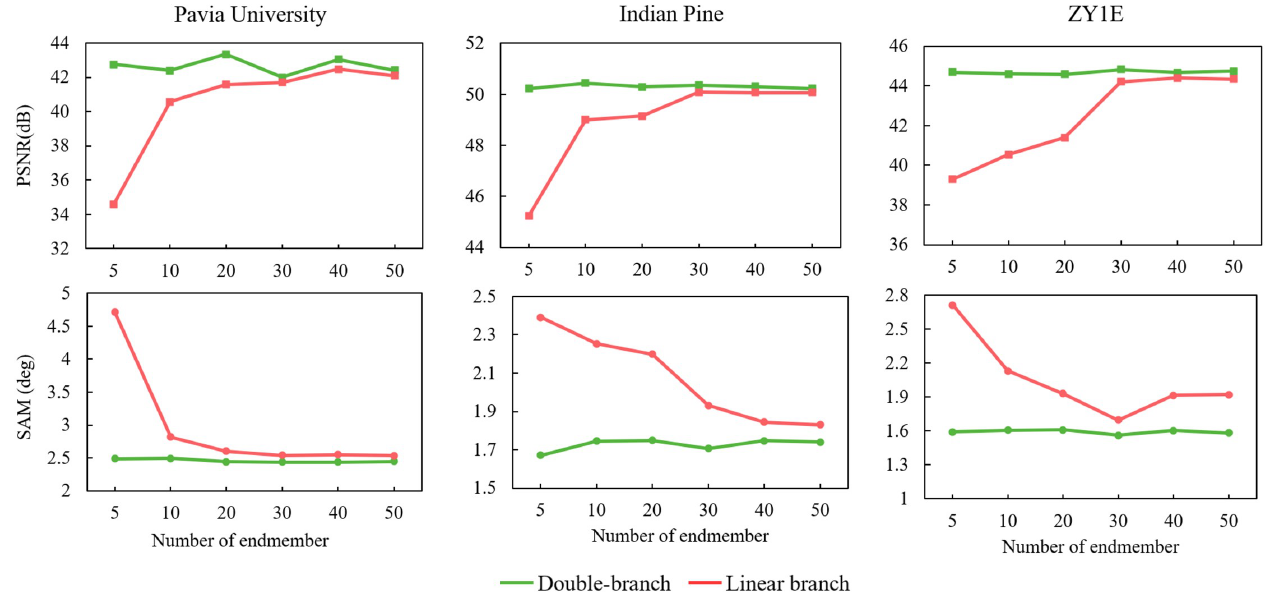
Figure 10. The variation of PSNR and SAM with endmember number on three